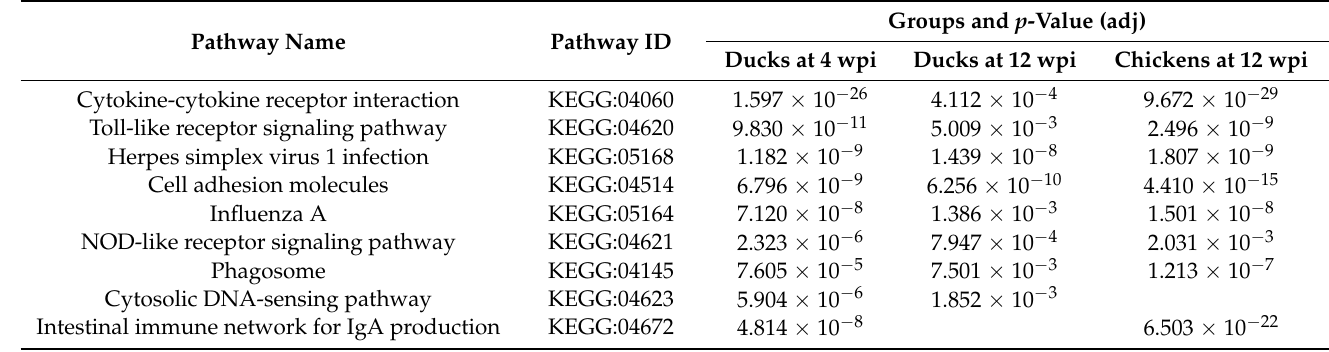
Table 6. Statistically significant enrichment of KEGG pathways in the brains of ABBV-1 infected Muscovy ducks and